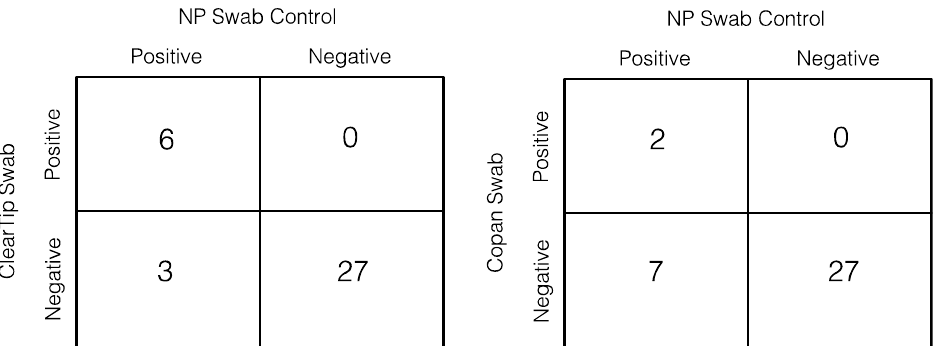
Figure 5. ClearTip TM concordance with control swabs. Summary of positive and negative samples detected with the ClearTip™ swab in comparison to Copan flocked swab. The statuses of participants enrolled in the study were confirmed by an EUA-approved RT-PCR COVID-19 virus test result, performed with NP flocked swabs.